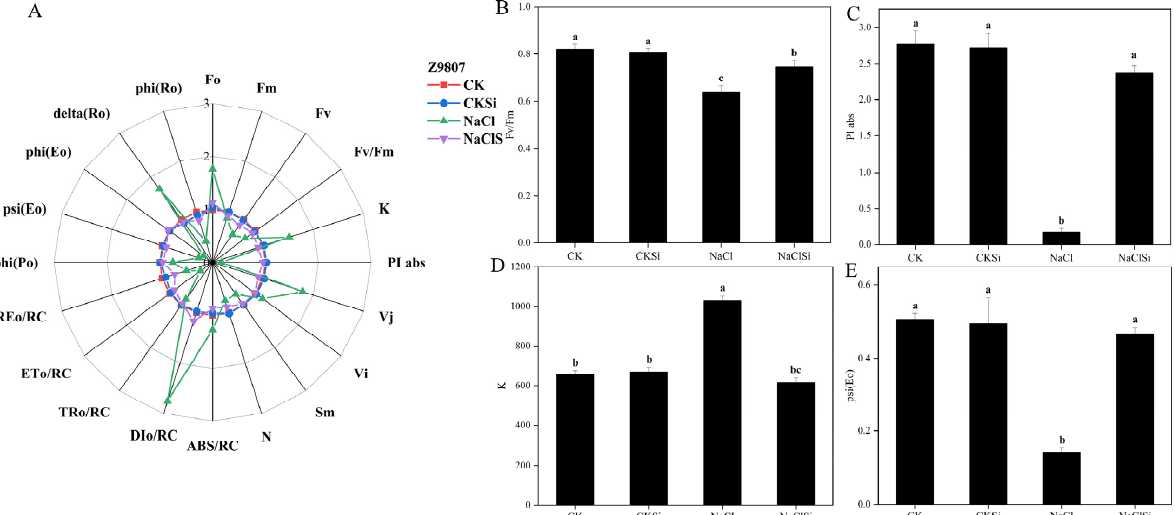
Figure 9. Analysis of selected JIP parameters derived from chlorophyll-a fluorescence in cotton genotype Z9807 under different treatments. ( A ) spider plot of a few fluorescence parameters of cotton leaves, and for each parameter, the value of control was set 1. ( B ) Fv/Fm. ( C ) fluorescence intensity of K point. ( D ) PIabs, performance index for energy conservation from photons absorbed by PSII until the reduction of intersystem electron acceptors. ( E ) Psi (Eo), the ratio of QA driven by exciton occupancy in excitons captured by the reaction center to reduce excitons to drive electron transfer to other electron acceptors in the electron transport chain beyond QA. Different letters mean significantly different among treatments at p ≤ 0.05.